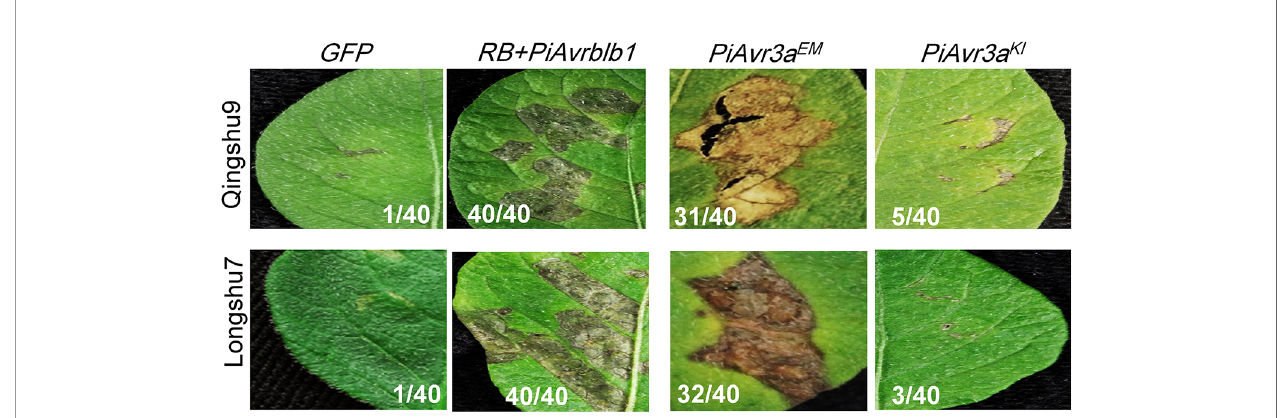
FIGURE 4 | Potato varieties Qingshu9 and Longshu7 were capable of recognizing P. infestans PiAvr3a EM . Both varieties were triggered with HR when in fi ltrated with agrobacteria carrying PiAvr3a EM , a virulent allele of PiAvr3a KI , but not by PiAvr3a KI . The A. tumefaciens AGL1 bacterial suspension with an OD 600 of 0.4 was used for in fi ltration of the 4-week-old potato leaves. The HR positive control was indicated by co-expression of PiAvrblb1 and RB , shown at the left side, and GFP was used as the negative control. The number of HR-responsive leaves/total number of the in fi ltrated leaves, were indicated. All pictures were taken at 5 – 7 dpi.